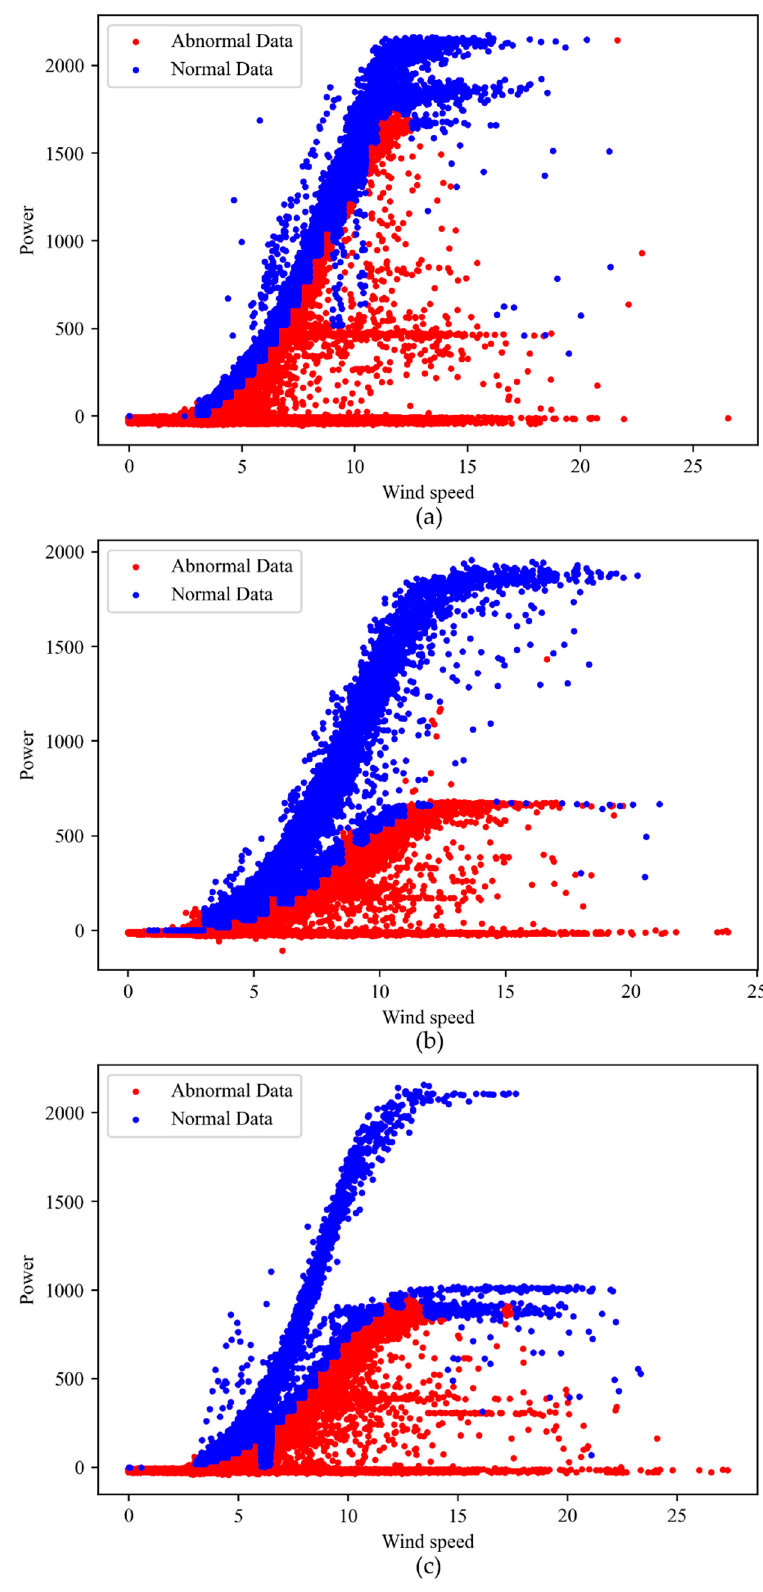
Figure 12. Abnormal data cleaning results using the CSOE algorithm: ( a ) #1 wind turbine: ( b ) #2 wind turbine; ( c ) #3 wind turbine.